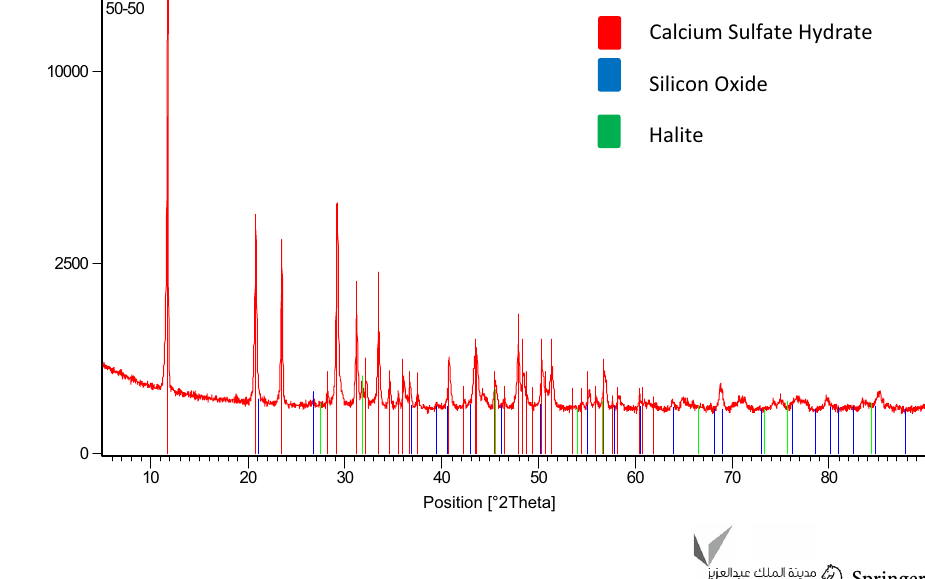
Fig. 4 XRD analysis of compat- ible water mix (1:1)